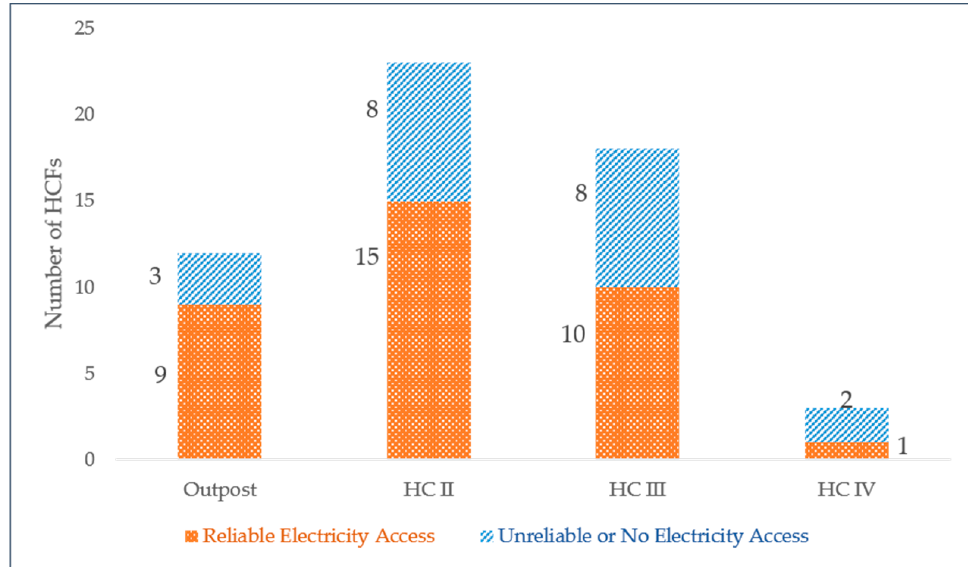
Figure 3. Electricity access in studied HCF.